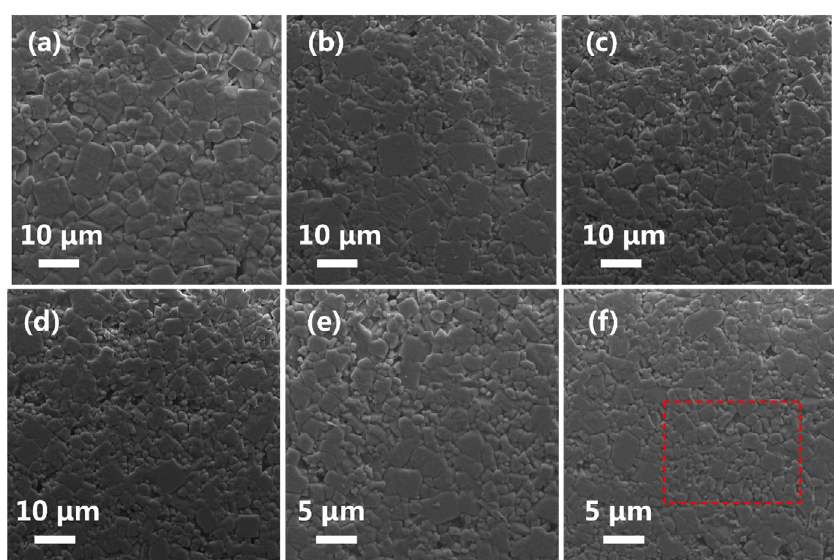
Fig. 4 SEM surface images of (0.99– x )KNNS–CZ– x BNH ceramics: (a) x = 0, (b) x = 0.01, (c) x = 0.02, (d) x = 0.03, (e) x = 0.04, and (f) x = 0.05.